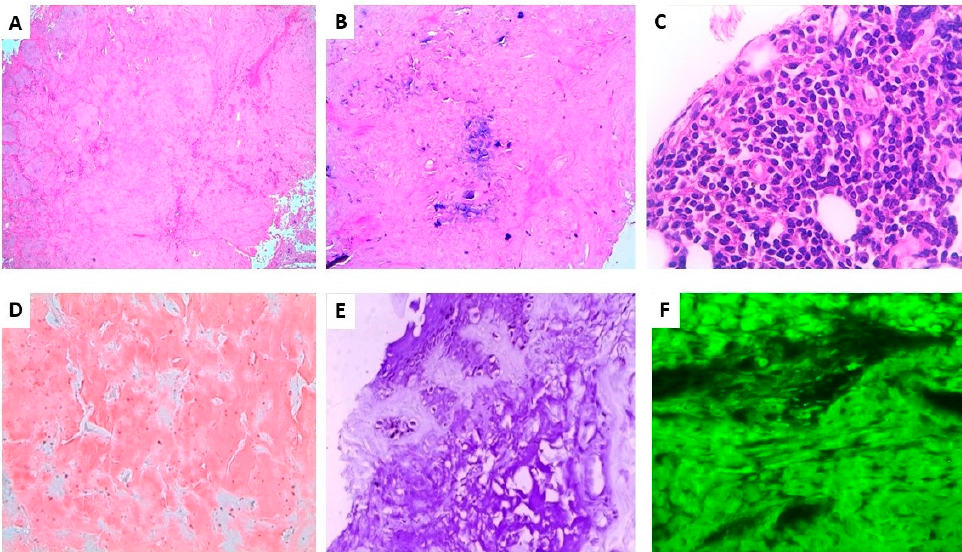
Figure 3. Histopathological findings of Case 2. ( A ). Nodular deposits of amorphous eosinophilic material in the dermis and subcutis (original magnification ×40) ( B ). Focal microcalcification inside the hyaline material (original magnification ×100) ( C ). Peripheral patchy focal infiltrate of lympho- cytes with many plasma cells (original magnification ×400) ( D ). Amorphous material intensely stained with Congo red (original magnification ×100) ( E ). Amorphous material intensely stained with crystal violet (original magnification ×100) ( F ). Positive apple green birefringence under polar- ized light (original magnification ×200) .